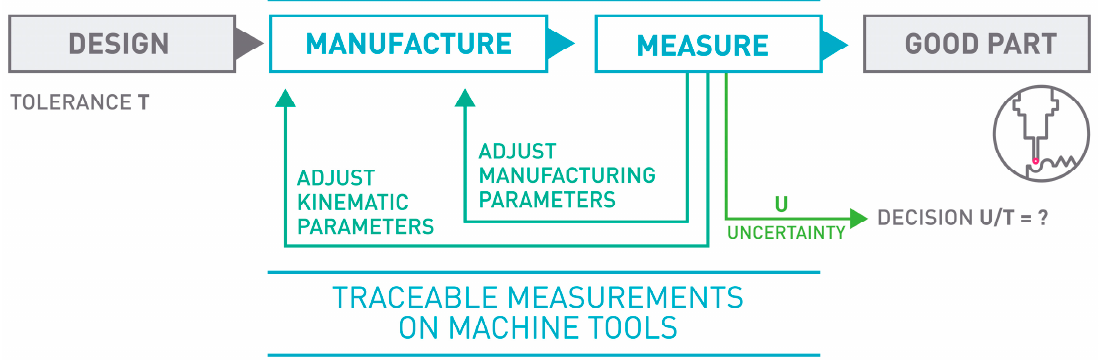
Figure 1. Traceable measurements on machine tools [3].